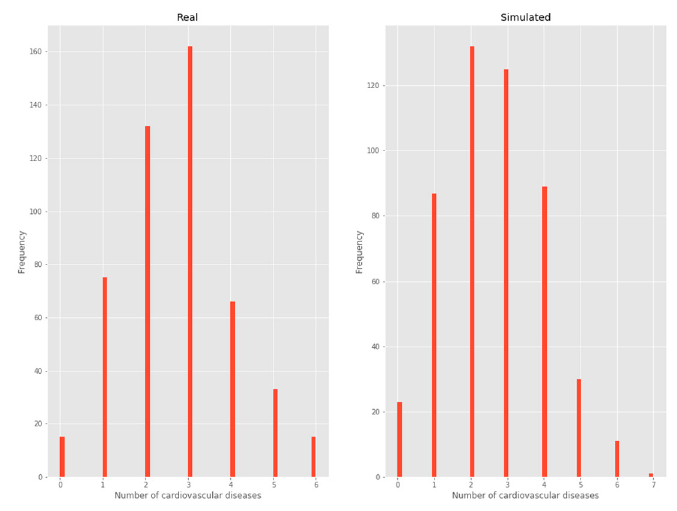
Figure 4. Number of chronic diseases.